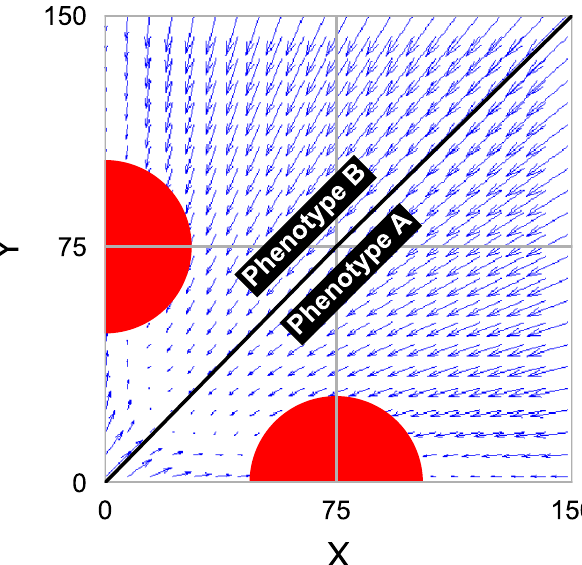
Fig 1. The phase-portrait diagram for the NDD model (based on Eq 1). In a bistable switch, two attractors (red semicircles) and, consequently, two phenotypes are available: A and B . The likelihood of a switch choosing state A over B depends on the number of the transcription factor associated with state A (TF X ) relative to the number of the transcription factor associated with state B (TF Y ), as well as the noise in its environment. The parameters used to generate this and the following figure are as follows: n = 2, β = 0.1, protein half-life = 10min, and protein dissociation constant = 10. Unless noted otherwise, these parameters are used in all the subsequent figures.